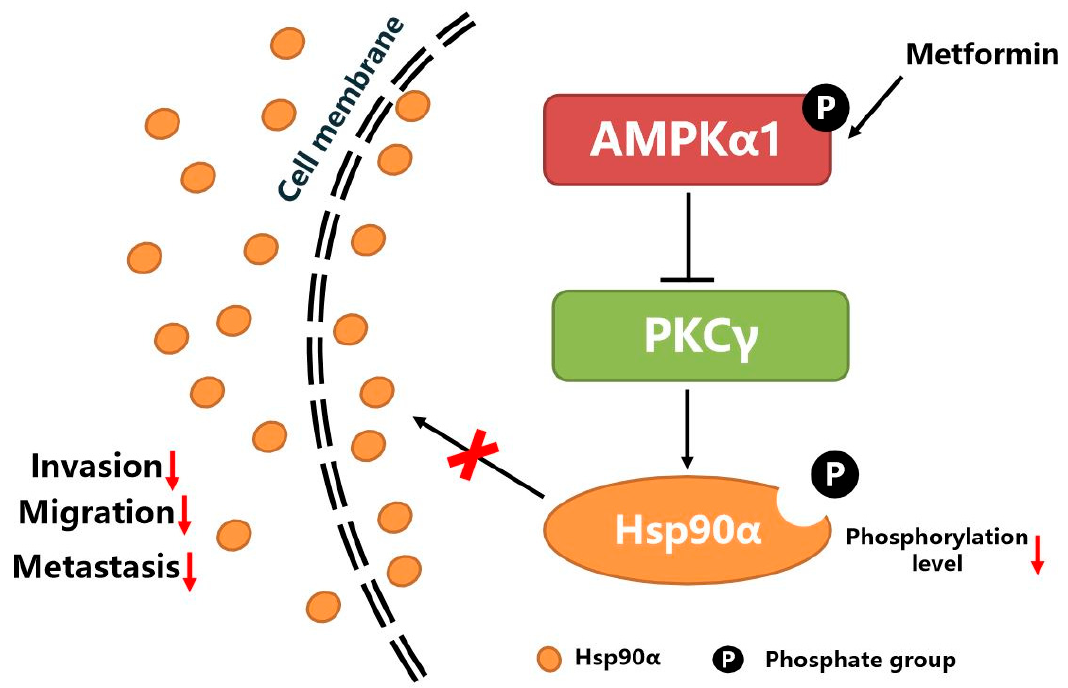
Figure 7. The graphical conclusion of the research: metformin inhibits tumor metastasis through suppressing Hsp90 α secretion in an AMPK α 1-PKC γ dependent manner.